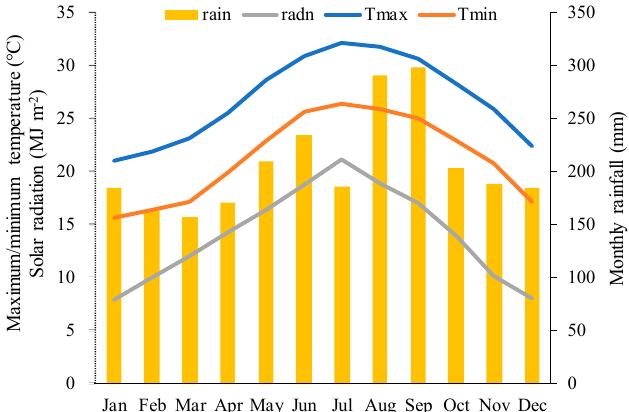
Figure 1. Average monthly climate data of the Japan International Research Center for Agricultural Sciences of Tropical Agricultural Research Front (JIRCAS–TARF) (2004–2019); rain, mean monthly rainfall (mm); radn, mean daily solar radiation (MJ m − 2 ); Tmax, mean daily maximum temperature (°C); Tmin, mean daily minimum temperature (°C).